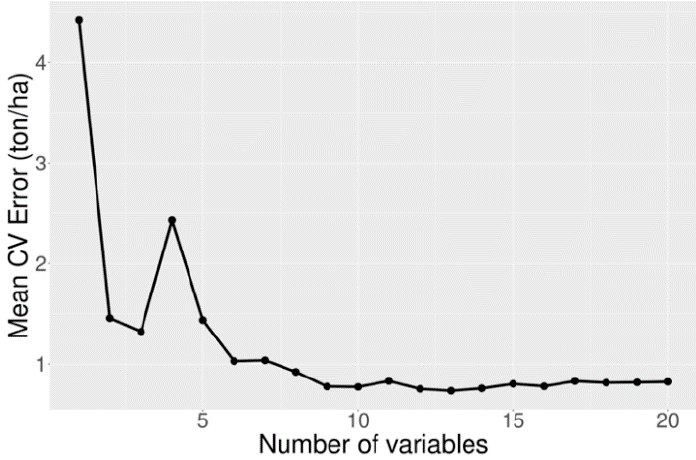
Figure 10. Mean cross-validation error versus the number of variables.